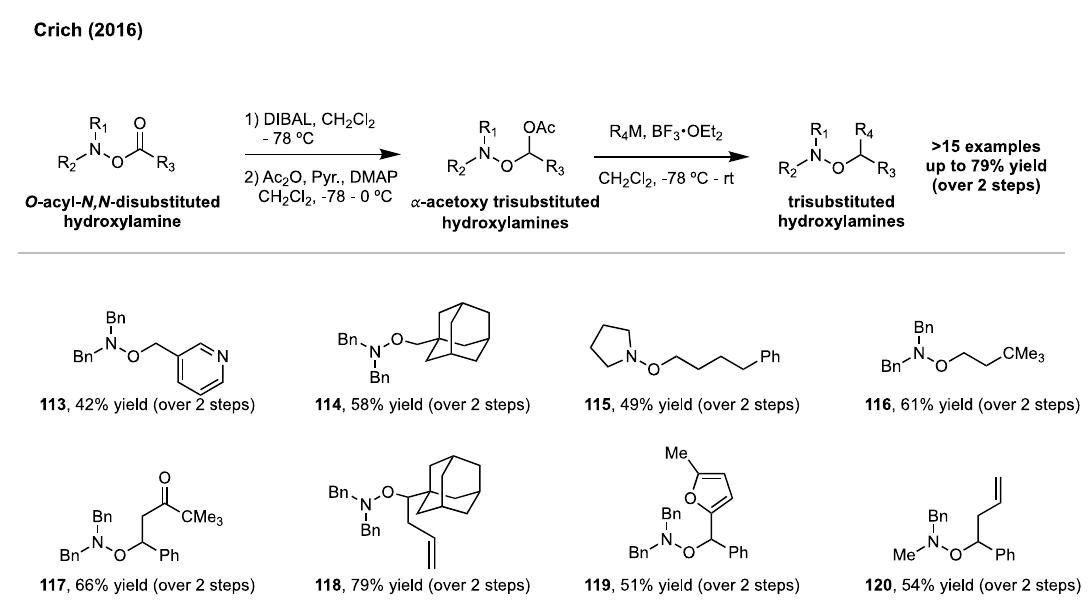
Scheme 11. Crich(cid:31)s 𝛼 -functionalization of O -acyl- N , N -disubstituted hydroxylamines for the syn- thesis of trisubstituted hydroxylamines